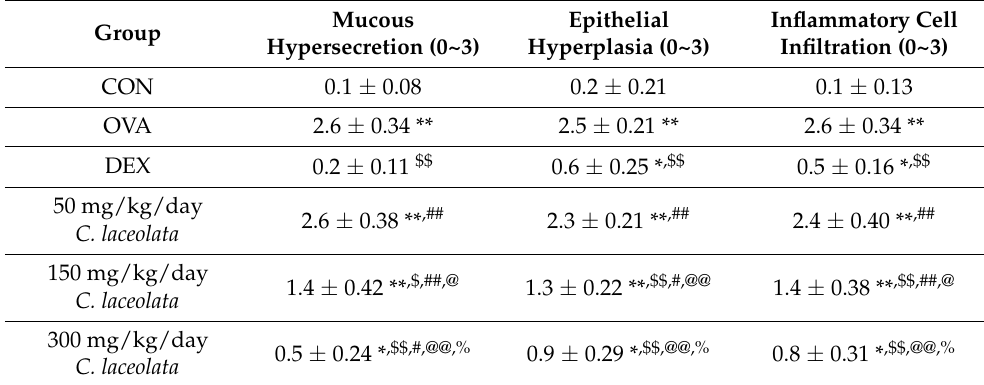
Table 1. The quantitative score chart of the histopathological changes in the lung. Mucous Group Hypersecretion